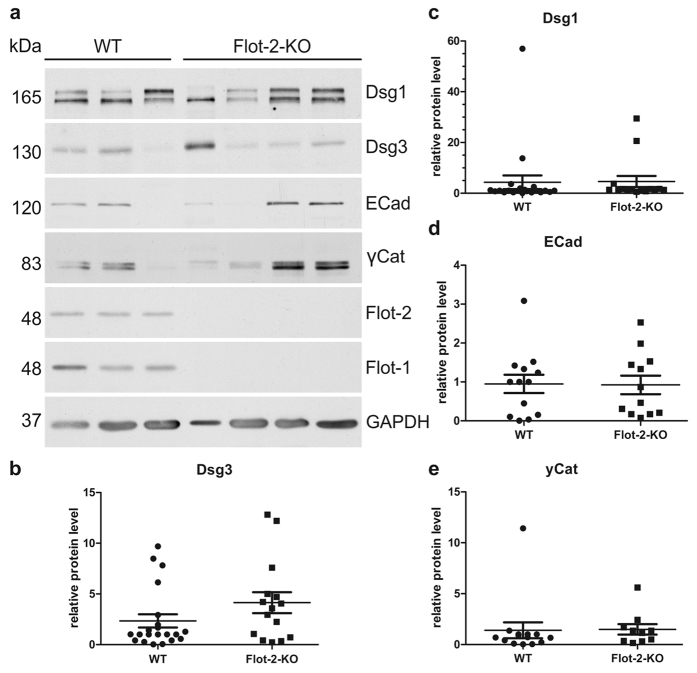
Expression of adhesion proteins in flotillin-2 knockout mouse skin.(a) Skin of adult wildtype (WT) and flotillin-2 knockout (Flot-2-KO) mice was lysed, and the levels of adhesion proteins were analysed by Western blot. (b–e) Western blot signals for Dsg3, Dsg1, E-cadherin and γ-catenin were quantified by scanning densitometry and normalised against GAPDH. Each data point represents the relative protein amount in a mouse skin lysate. A randomly chosen wildtype sample was set as 1, and all other samples were normalised to it. The mean ± SD is indicated for each protein. Number of analysed animals: (b) WT: 21, Flot-2-KO: 15. (c) WT: 21, Flot-2-KO: 15. (d) WT: 13, Flot-2-KO: 12. e) WT: 14, Flot-2-KO: 10.